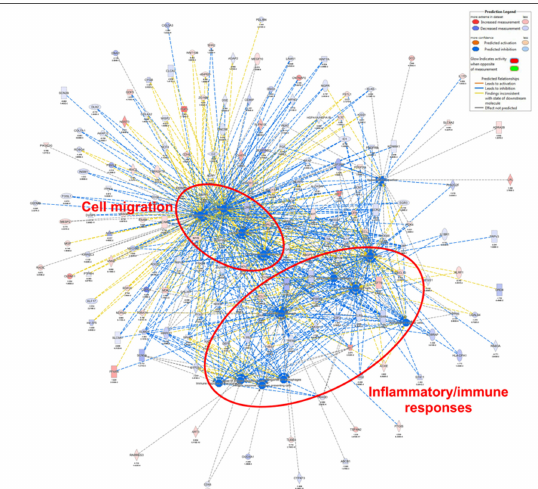
Figure 5. Next generation sequencing data suggesting ORAI3 silencing reduces the expression of genes associated with cell migratory and inflammatory/immune responses. Networks of genes associated with biological functions (nodes) that were significantly altered with ORAI3 siRNA-mediated silencing after hypoxia (1% O 2 , 72 h), identified using Ingenuity Pathways Analysis. Suppressed biological functions are represented in blue nodes. Only biological functions with a z-score below − 2.3 are shown (refer to Table S1). No processes were augmented. Biological functions related to a same category were manually circled and labelled with cell migration or inflammatory/immune responses.